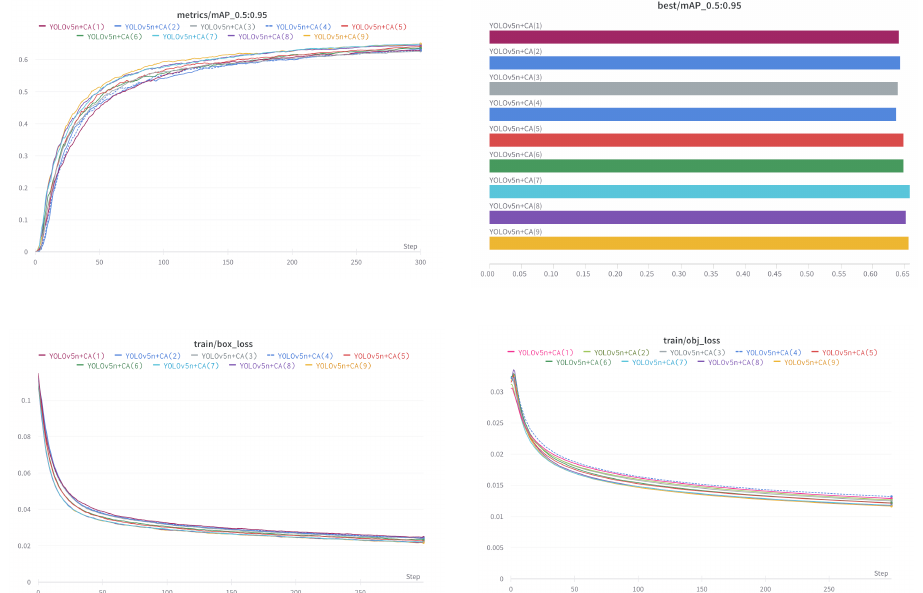
Figure 9. Characteristic curves of different fusion configurations. The upper left subgraph shows the change of mAP scores of different models with the training epoch. The upper right subgraph shows the maximum mAP distribution of each model in 300 epochs. The lower left and lower right subgraphs show the bounding box loss and the confidential loss in the training process, respectively. The curves are smoothed for more